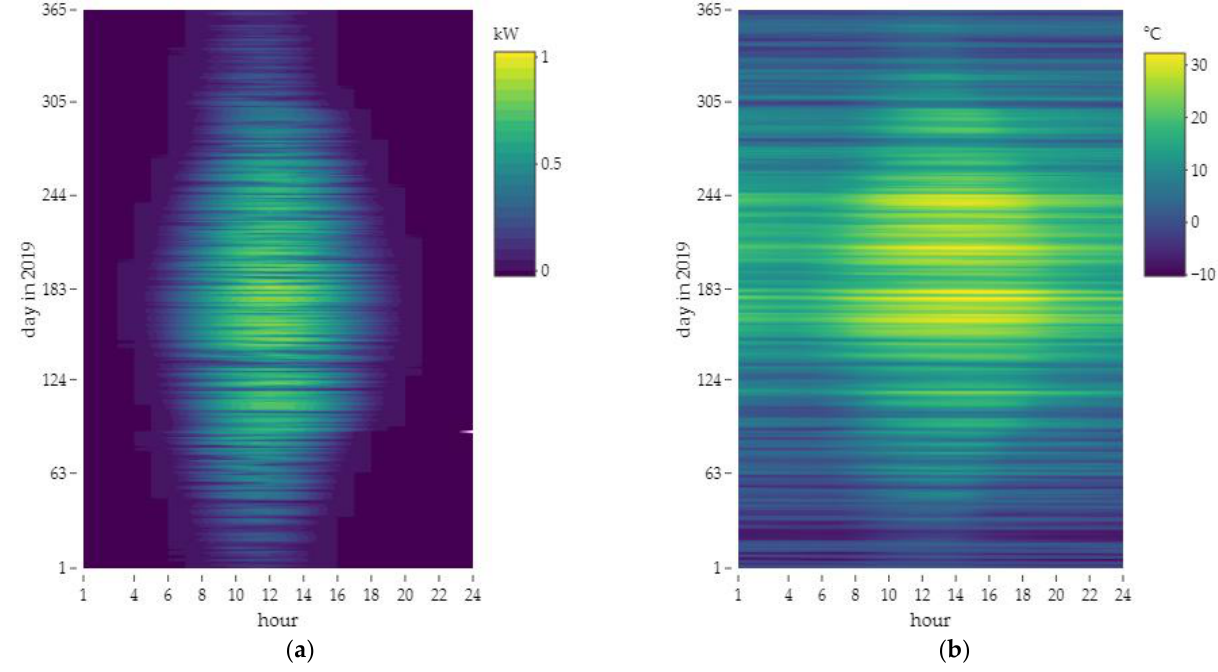
Figure 7. Weather data for the centre of Poland according to the weighted power of photovoltaic installations created under the “My Electricity” program, data for 2019: ( a ) solar radiation intensity on the horizontal plane; ( b ) outdoor temperature.